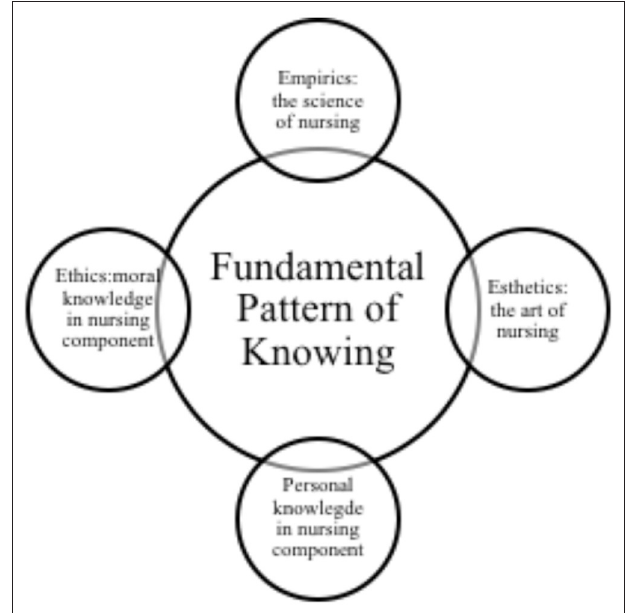
FIGURE 1 | The fundamental pattern of knowing in